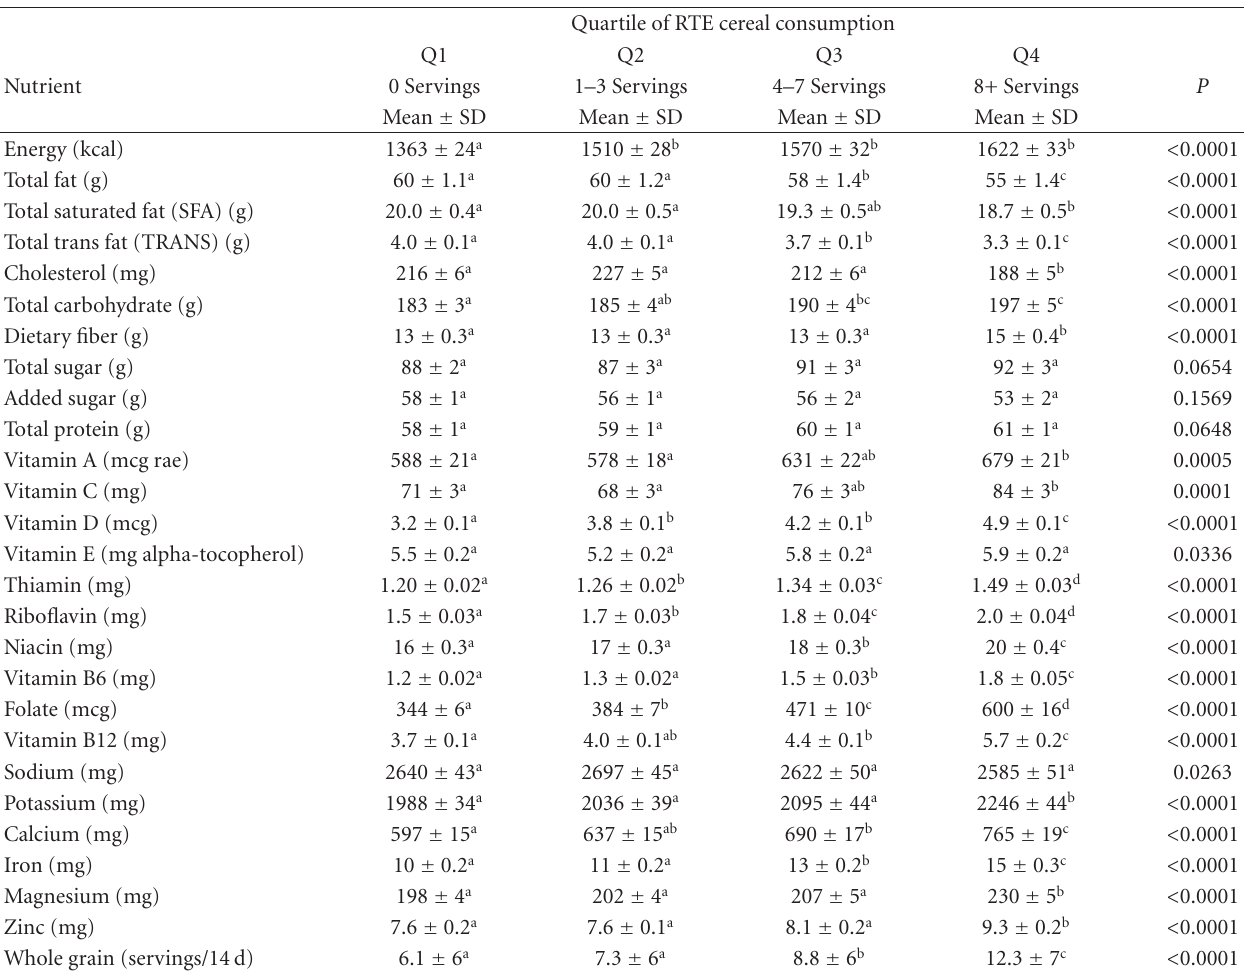
Table 3: Adjusted ∗ mean daily nutrient intake for adult women, ages 55+, by quartile of RTE cereal consumption